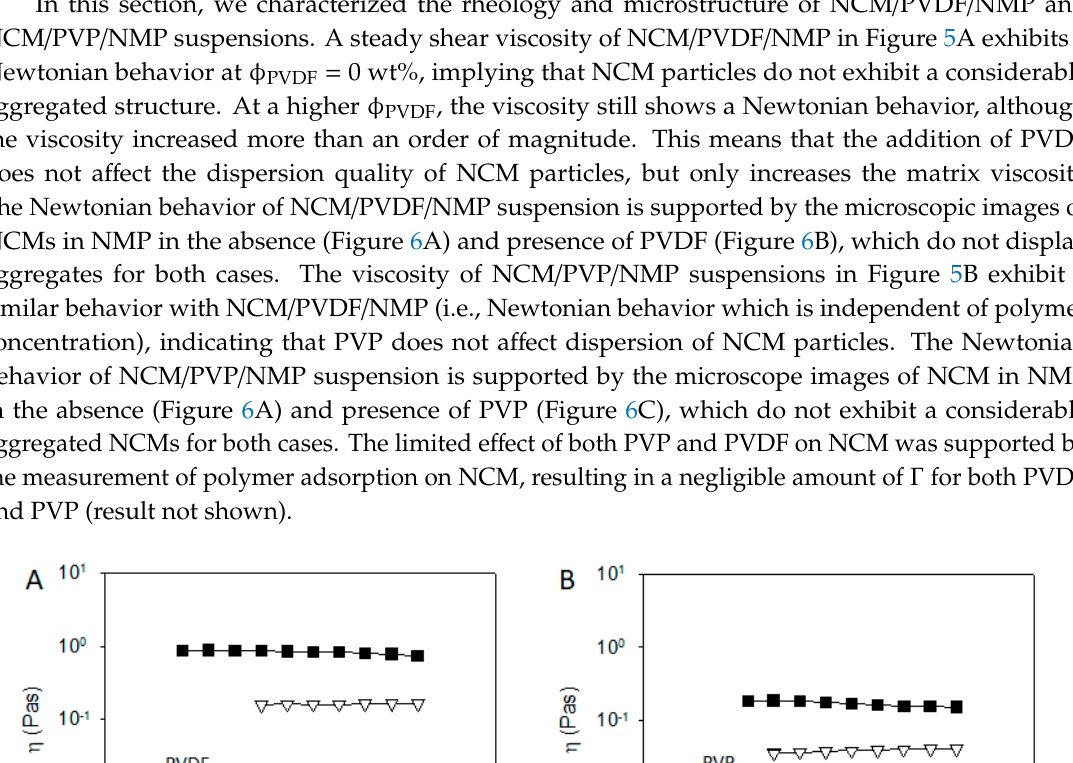
Figure 5. Steady shear viscosity of ( A ) Li(Ni 1/3 Mn 1/3 Co 1/3 )O 2 (NCM)/PVDF/NMP and ( B ) NCM NMP mixtures of 60wt% ( = 25 vol%) of NCM and 2.5 wt%